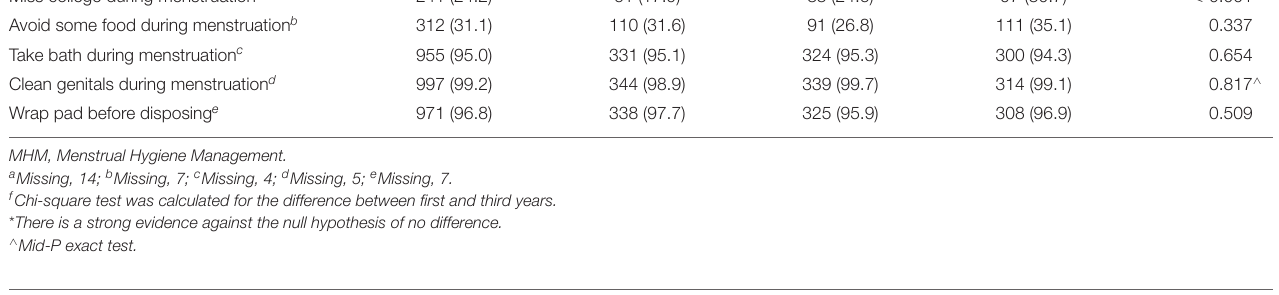
TABLE 4 | Status of menstrual hygiene management facilities in all the 10 government colleges of Bhutan,